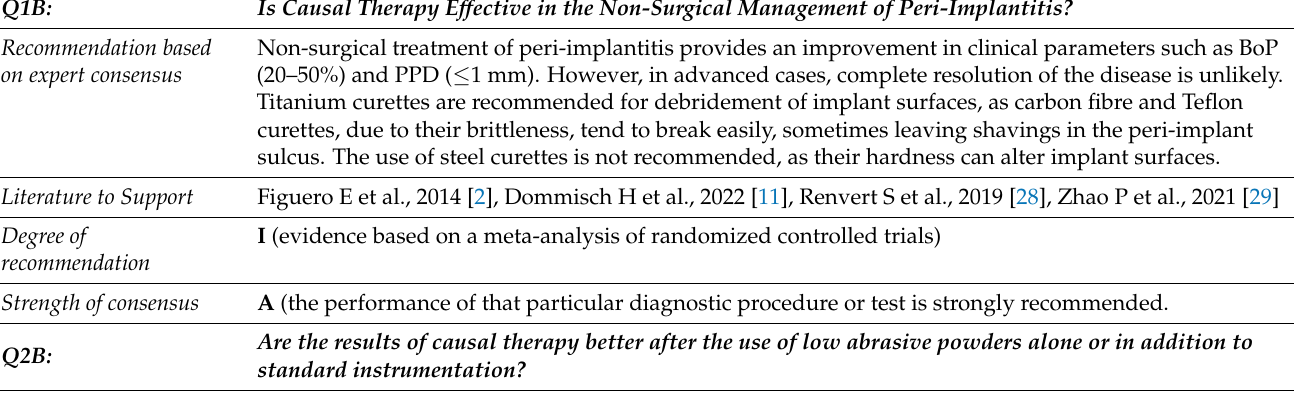
Table 3. Peri-Implantitis